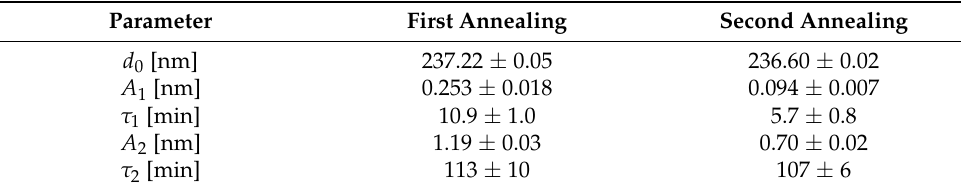
Table 1. Double exponential decay parameters, fitted to the data in Figure